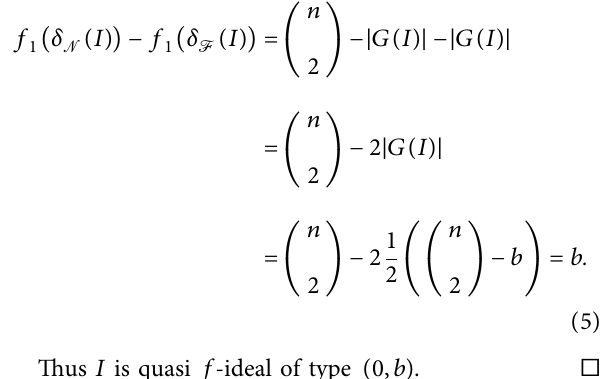
Figure 2: Non-pure quasi f -simplicial complex of type (0, 1, 0).